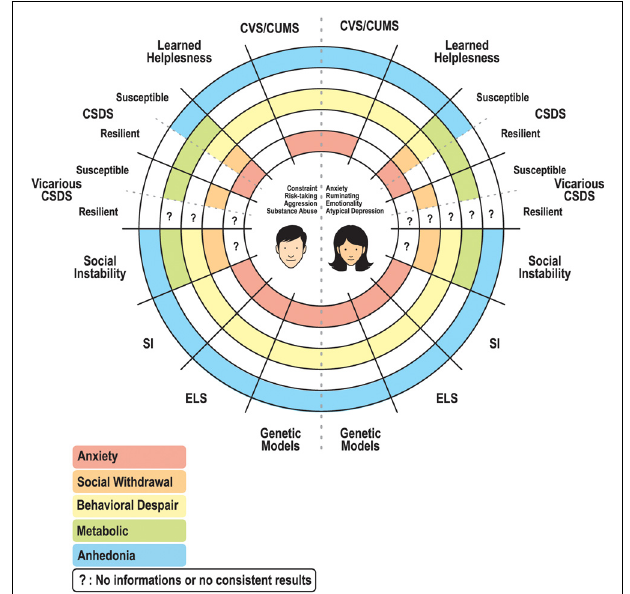
FIGURE 1 | Schematic representation of a circle diagram regrouping the main symptoms (anxiety, social withdrawal, behavioral despair, metabolic dysregulation, and anhedonia) characterizing stress responses in a variety of animal models in males and females. Some unknown results remain, particularly for the resilient group of the vicarious CSDS model, as well as the controversial results concerning the anxiety displayed or not in the social instability model. Abbreviations: CVS/CUMS, chronic variable stress/chronic unpredictable mild stress; CSDS, chronic social defeat stress; SI, social isolation; ELS, early life